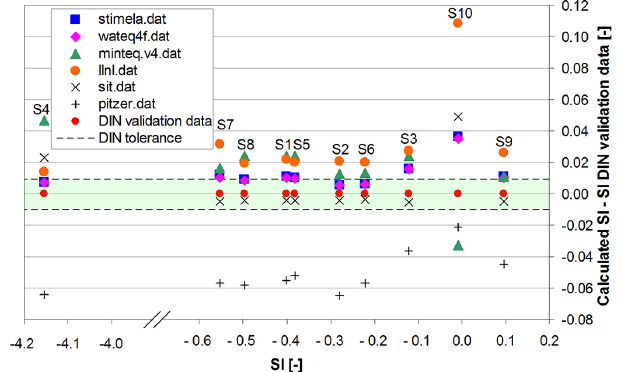
Figure 3. Deviations of the SIs calculated in PHREEQC with widely used chemical databases, from the SIs given in the DIN val- idation data set for the 10 water quality samples S1 to S10 (see Table